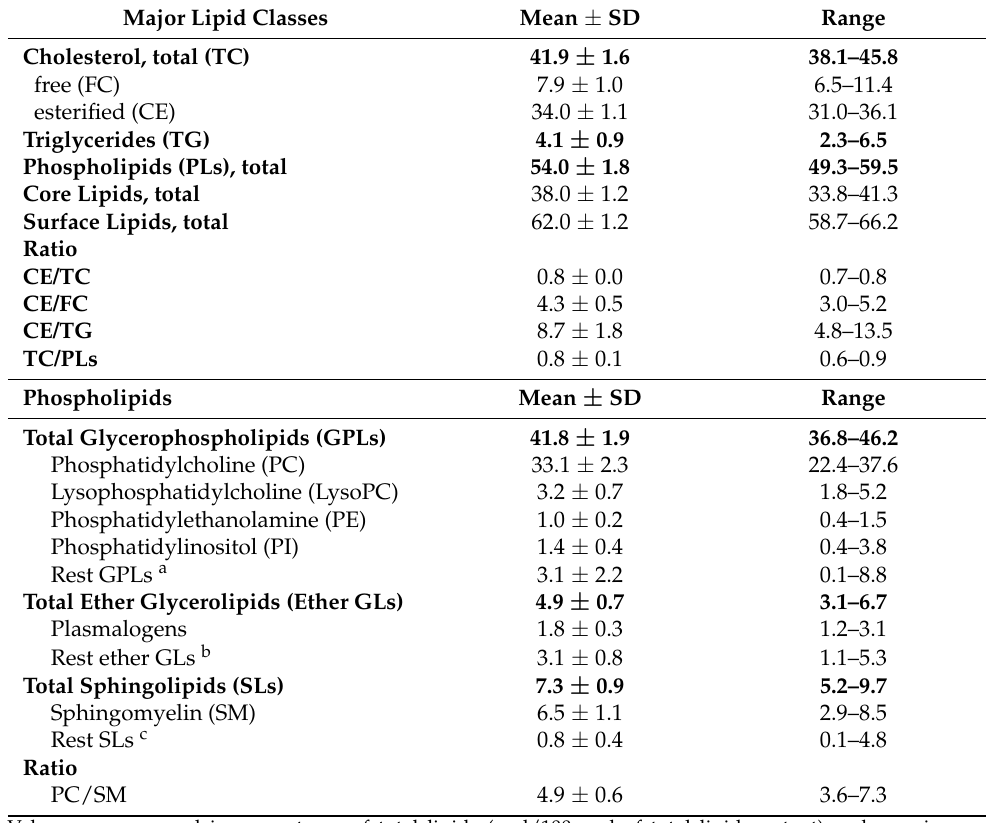
(Table 2). PLs that quantitatively predominate in the HDL lipidome (54 ± 1.8, expressed in percentage of total HDL lipids) were subclassified in glycerophospholipids (GPLs), ether glycerolipids (ether GLs), and sphingolipids (SLs). Individual PLs molecules such as phosphatidylcholine (PC), lysophosphatidylcholine (lysoPC), phosphatidylethanolamine (PE), phosphatidylinositol (PI) and sphingomyelin (SM) have been quantified from charac- teristic well-resolved signals in the proton NMR fingerprint. PC, the major GPLs of HDLs, accounted for about 33% of the total lipids, whereas SM, the major SL class, was estimated at about 6.5% (Table 2). The rest GPLs are mainly attributed to phosphatidylserine (PS) and cardiolipin, the rest ether GLs to the platelet-activating factor (PAF), and finally the rest SLs are mainly attributed to ceramide, sphingosine-1-phosphate (S1P). The molecular ratio of PC/SM was calculated to be nearly five. Table 2. HDL composition in percentage of major lipid classes and phospholipid molecules in the whole healthy population. Major Lipid Classes Mean ± SD